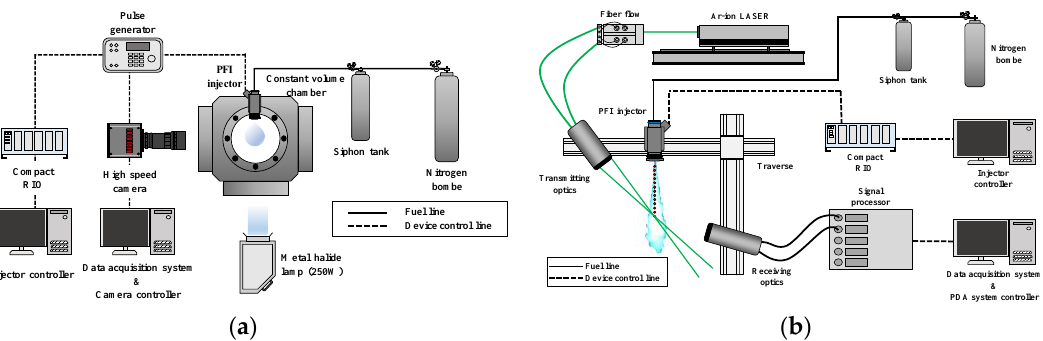
Figure 1. Schematic diagram of ( a ) spray visualization system ( b ) droplet size velocity measurement system (PDA system).